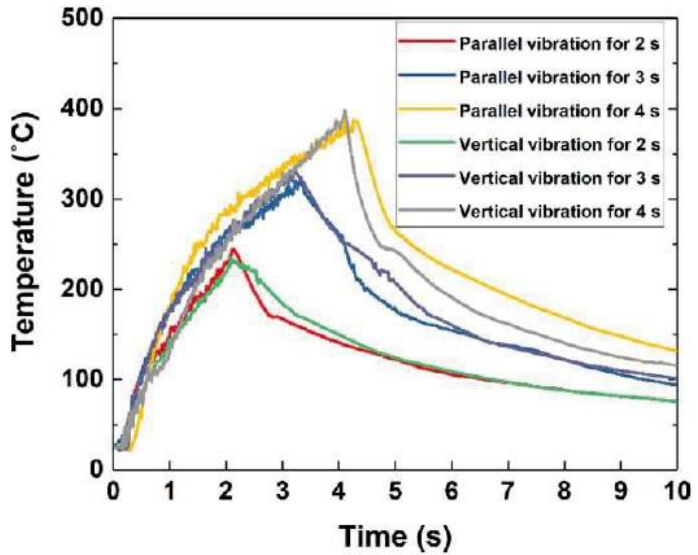
Figure 8. Thermal cycles during USW with different vibration directions and welding time under 65 psi force [34].